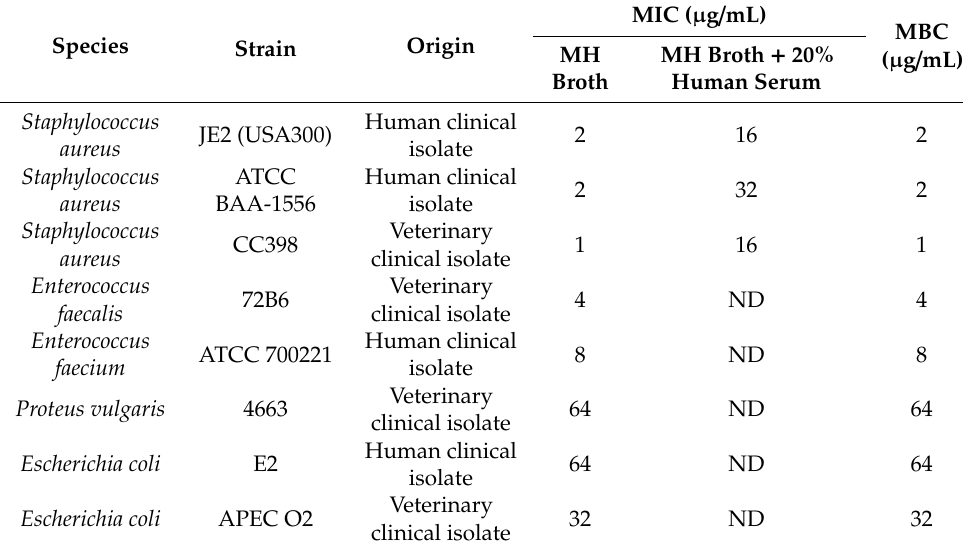
Table 1. Antimicrobial activity of T5 .